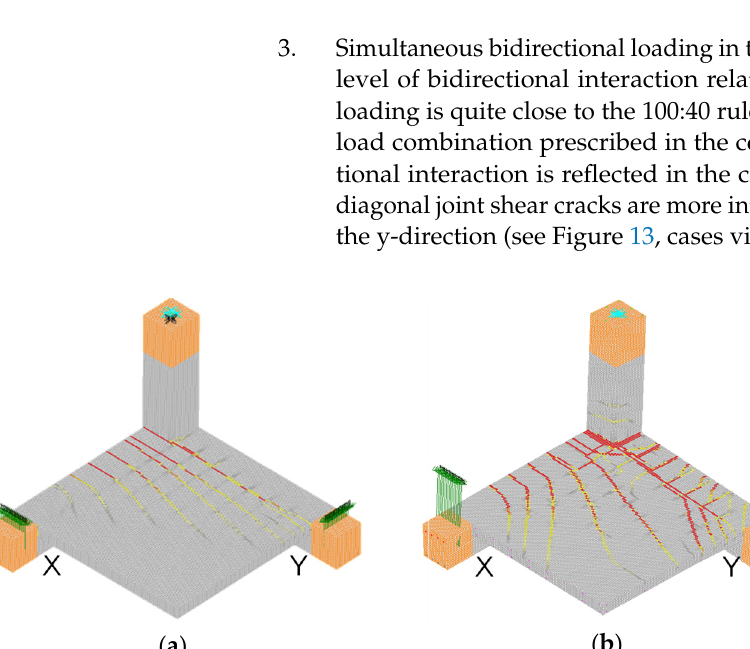
Figure 12. Crack pattern on the slab for different loading scenario ( a ) X_D; Y_m, ( b ) X_D; Y_p5D, ( c ) X_D; Y_D.